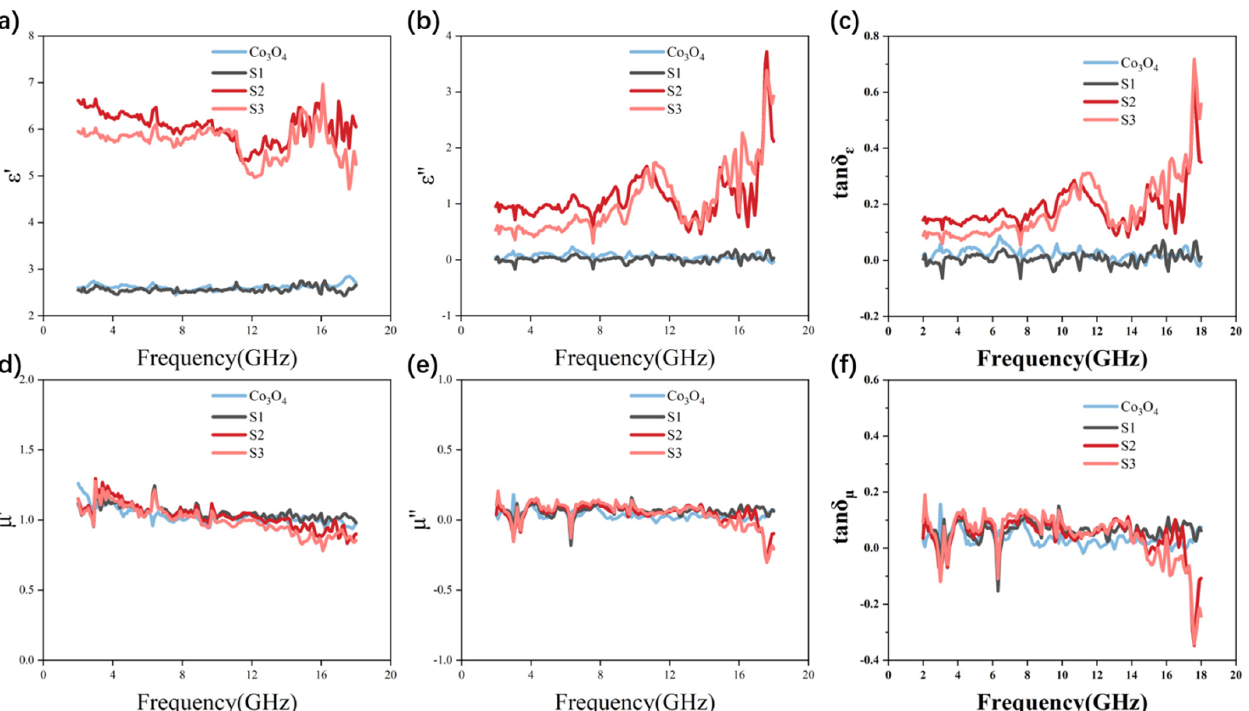
Figure 5. Electromagnetic parameters of Co 3 O 4 S1 S2, S3: ( a ) ε′ , ( b ) ε″ , ( c ) dielectric tangent loss factor tan δε , ( d ) μ′ , ( e ) μ″ , ( f ) magnetic loss tangent factor tan δ μ .